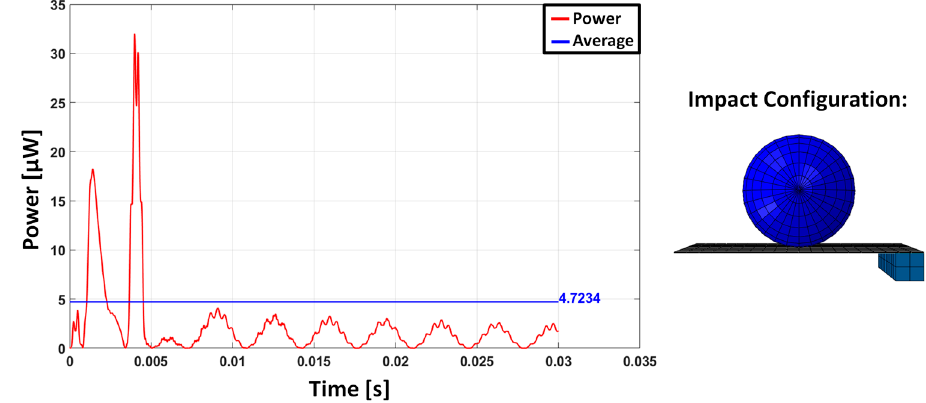
Figure 7. Instantaneous power, and average value computed over a time duration of 30 ms in the case of TM10 with impact position L/2.